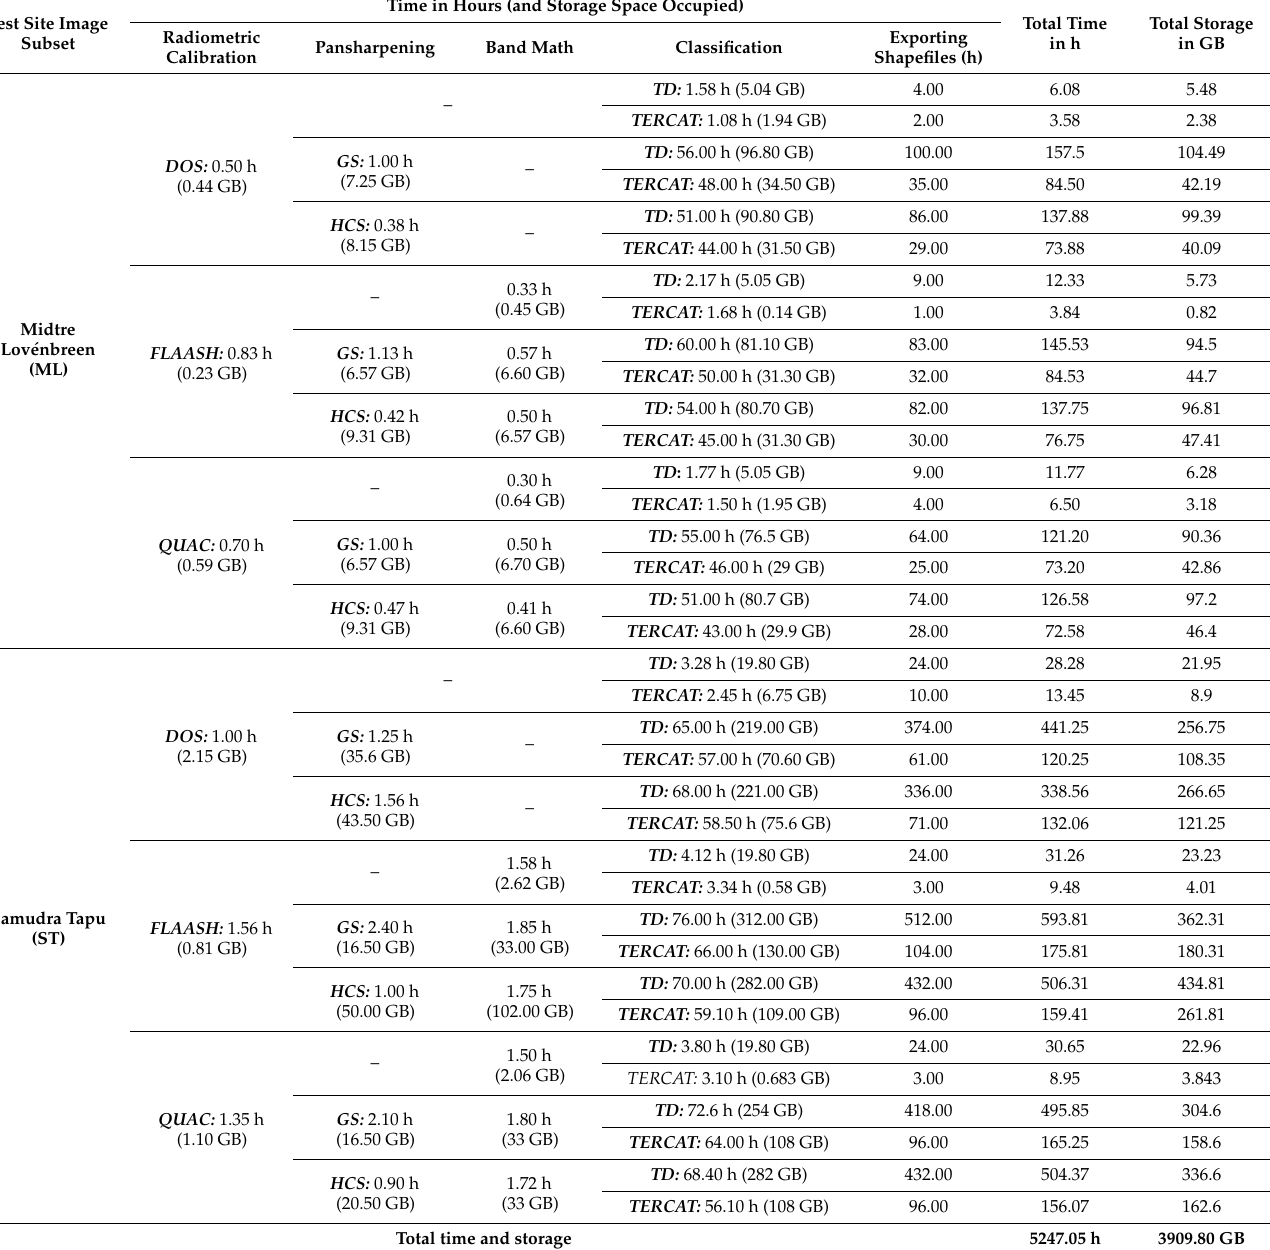
Table 11. Stepwise break down of the time taken and storage space occupied at each processing step, which included radiometric calibration, pansharpening, band math conversion (0 to 1 reflectance units), classification, conversion of raster thematic data to vector files, and export of the resultant vector files. The time is displayed in hours, and the space occupied is provided in parenthesis after the